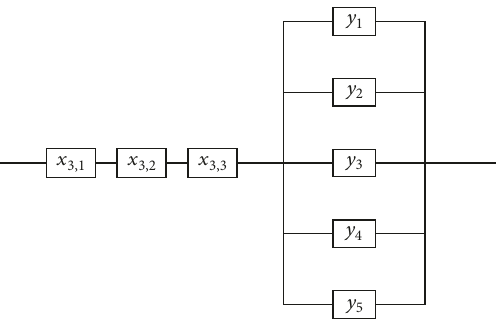
Figure 10: Block diagram of module 𝑀 𝑁,4 .